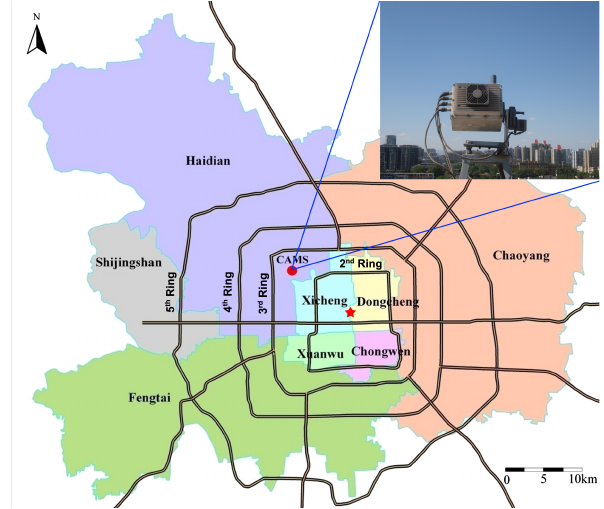
Fig. 1. A map of the Beijing city. The red dot indicates the CMA observation site, and the red star the position of Tian-An-Men, the center point of the city. A photo inside shows the surrounding envi- ronment of the instrument in the view direction (towards the